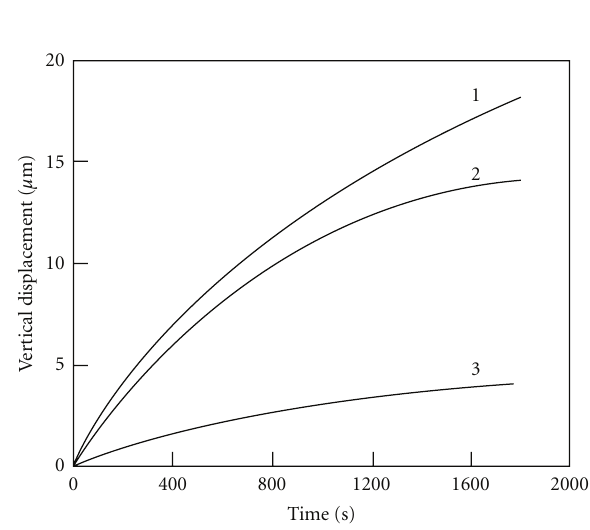
Figure 2: Wear profiles of (1) Ti substrate and Co clad Ti lased with laser power density, P of 0.212 kW/mm 2 and scan speed, v of 14.3mm/s for (2) without Cu interlayer and with Cu interlayer with thickness of (3) 30 μ m at 1kg